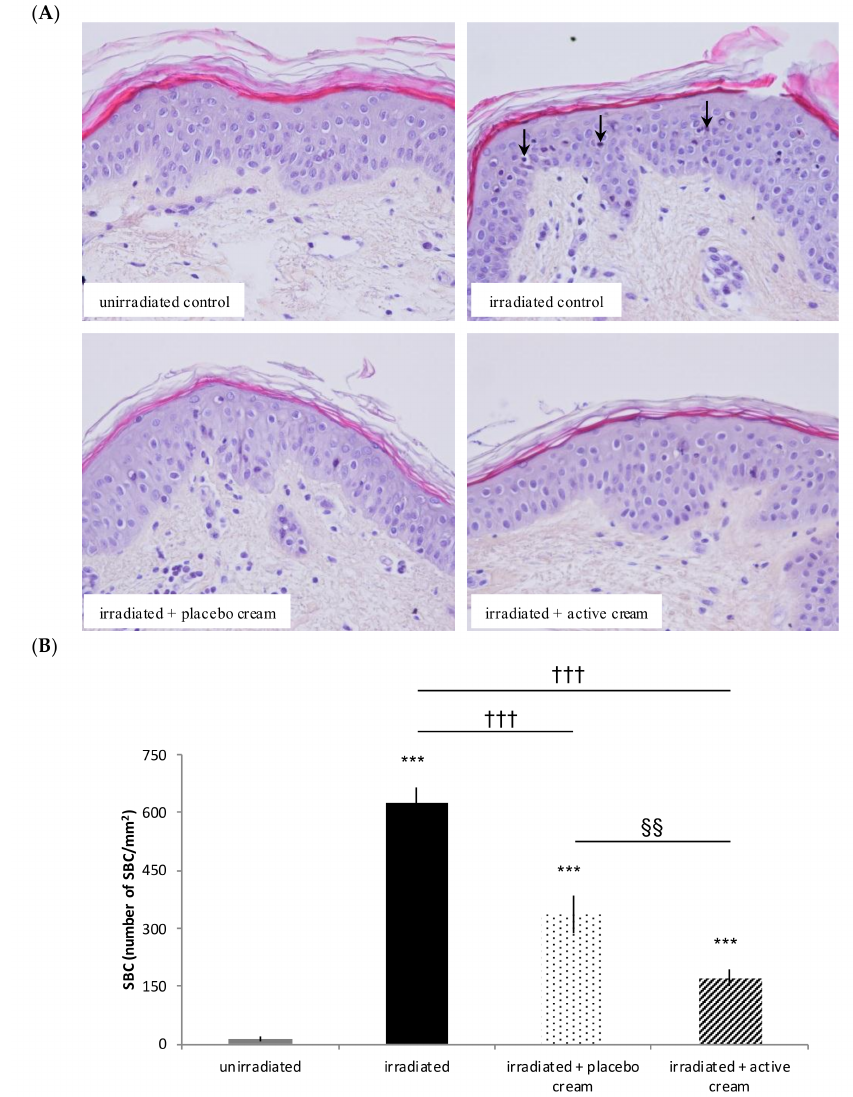
Figure 3. Influence of melon concentrate application on the formation of Sun Burn Cells (SBC) after irradiation of human skin explants. ( A ) HES histochemical staining of human skin explants for SBC observation. Arrows show SBC. ( B ) SBC were quantified after histochemistry analysis on five transverse sections per skin explant. Results are expressed in SBC/mm 2 of skin. *** p < 0.001 compared with unirradiated skin explants, ††† p < 0.001 compared with irradiated skin explants, and §§ < 0.01 effect of melon concentrate treatment compared with the placebo